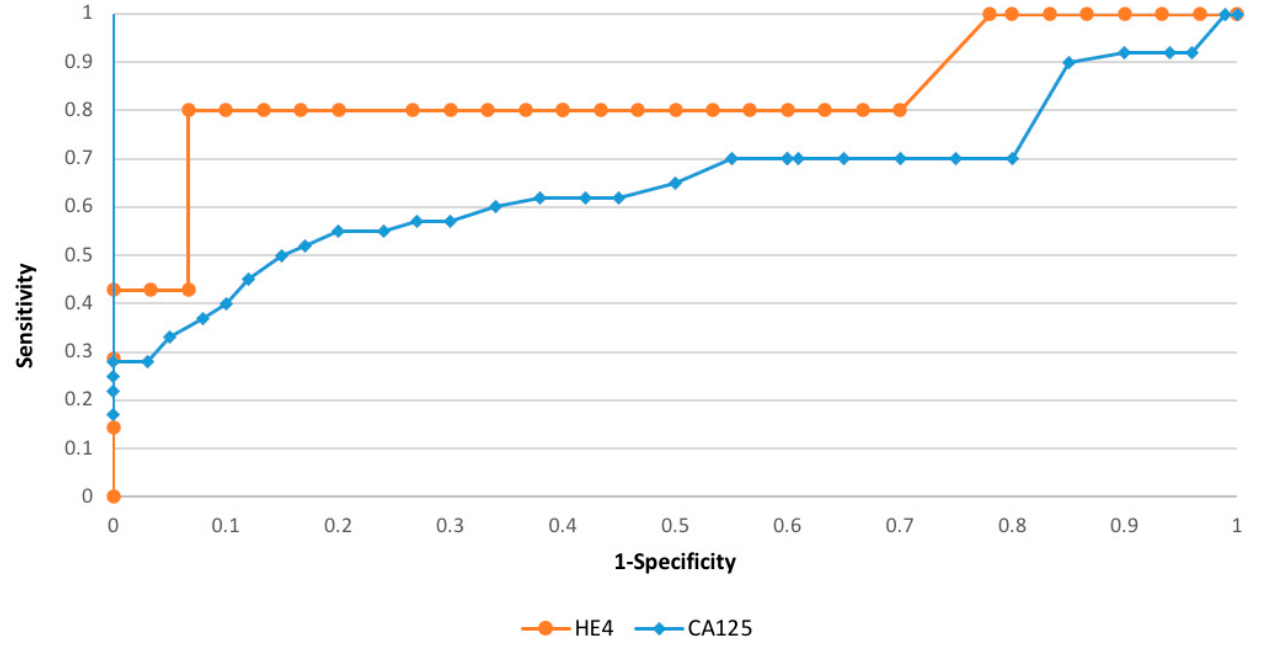
Figure 3. The ROC curves for HE4 markers depending on grading (AUC = 0.78). In case of recurrence, after the exclusion of a disseminated form of the disease, patients presenting with a single recurrent tumor were qualified for cytoreductive surgery. Based on the ROC curves obtained in the study, we established the cut-off point for HE4 at 186 pmol/L, which should allow for total debulking surgery (to R0) in patients with endometrial cancer. There was no statistically significant correlation with the possibility of cytoreduction for the CA125 marker. The differences in the concentrations of both markers were statistically significant at the time of diagnosis and of tumor recurrence— Figures 4 and 5. Relapse of the disease occurred in patients according to the initial stage of the disease. A detailed breakdown depending on the staging is presented in Table 3. Table 4 also shows the median values of the HE4 and CA125 markers at the time of diagnosis and later, depending on the time of observation or relapse.